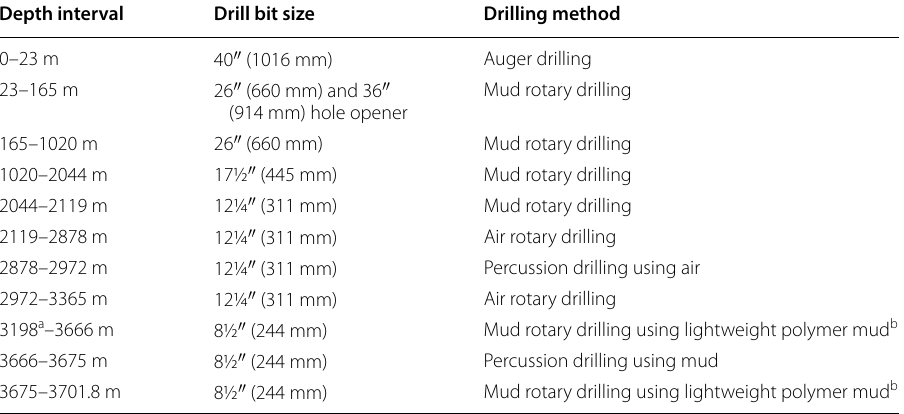
The crystalline basement was reached at 1946 m depth a Due to whipstock installation b Mud weight between 1.02 and 1.05 g/cm 3